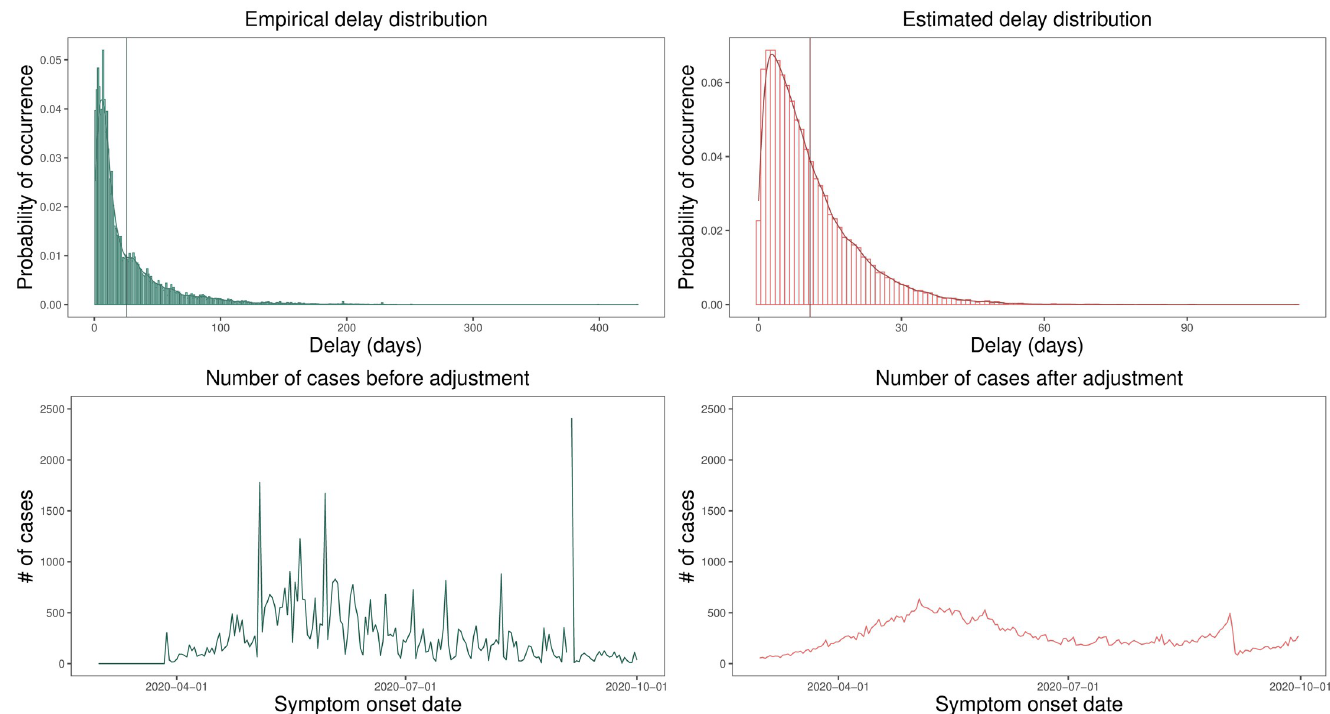
Fig 1. Probability distribution of the delay in the notified cases. The distributions of delay and number of cases estimated from the data notified by Opendata SUS platform and the Coronavirus Panel before and after adjustments of the lag between symptom onset and official notification in Fortaleza/CE (Brazil). From right to left, we have: empirical delay distribution (with μ = 25.72 and σ = 31.85), estimated delay distribution(with μ = 10.85 and σ = 9.61), cases distribution before fits, cases distribution after fits. In addition, μ is the mean of the distribution and σ is the standard deviation and the vertical lines on the first and second plots represent the mean of the delay value in each analyzed